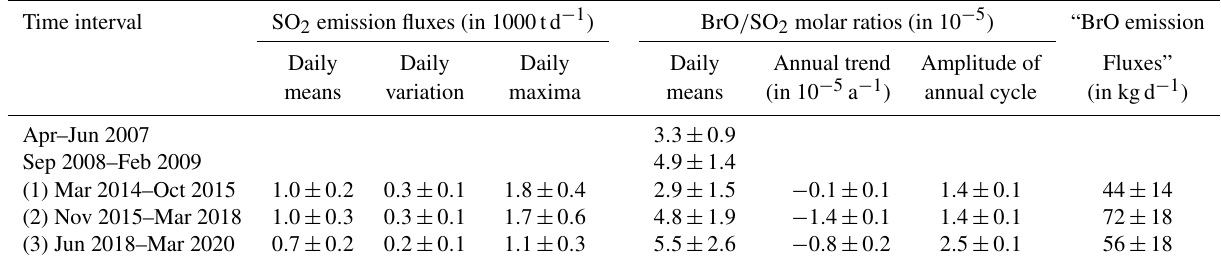
Table 5. Main statistical properties of the spectroscopic results for Caracol station. Early BrO / SO 2 NOVAC observations between 2007 and 2009 are listed for completeness. The daily variations are based on the standard deviations of the single days. The given errors are standard deviations, except for the annual trend and the amplitude of the annual cycle for the BrO / SO 2 molar ratios where the errors refer to the standard regression